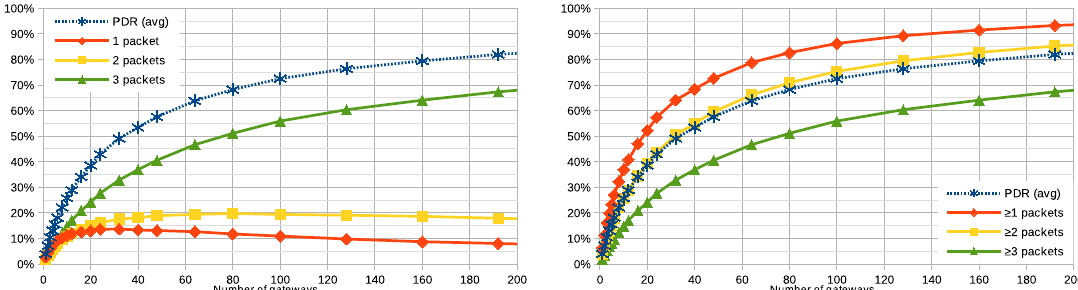
Figure 5. PDR and ratio of user nodes successfully communicating, in a function of the number of gateways. The left graph plots the number of user nodes from which one, two, and three packets have been received. Right graph plots the number of user nodes from which ≥ 1, ≥ 2 and ≥ 3 packets have been